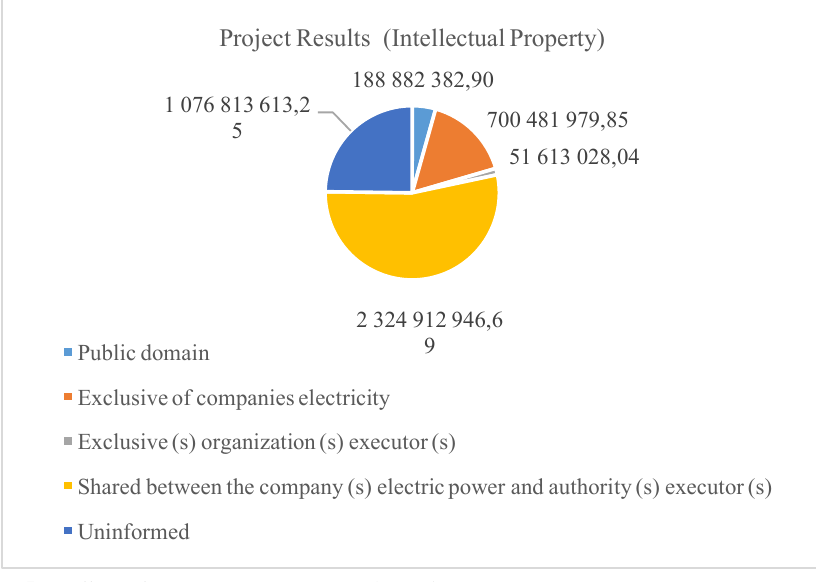
Fig. 5. Intellectual Property (ANEEL, march